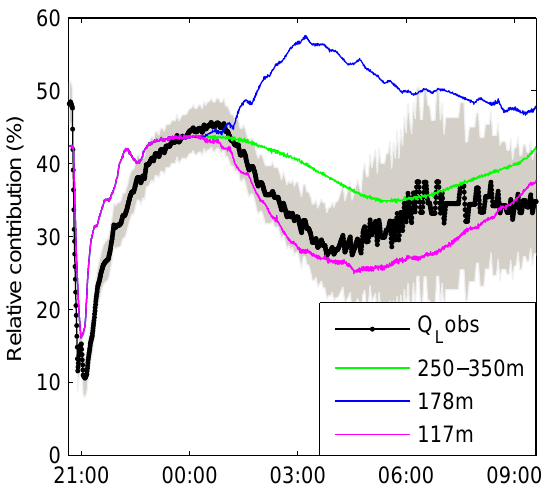
Fig. 7. Observed and simulated (3 scenarios) relative contribu- tion of the second source. The different scenarios are the locations where the new source was added. Shaded area is observed contri- bution ± 1 σ